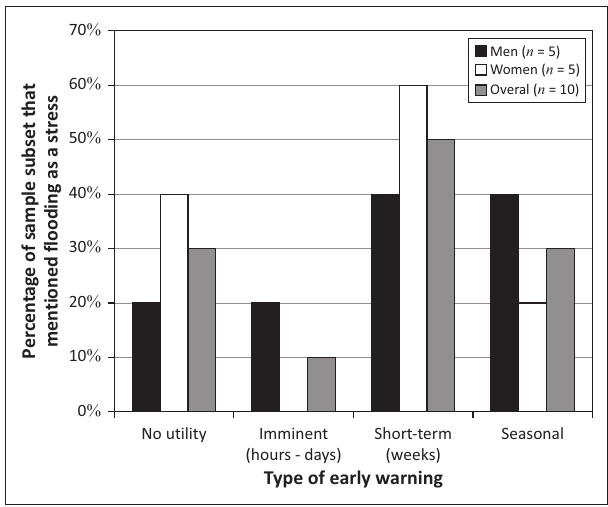
FIGURE 22: Answers of those in Group W who were asked what kinds of early warning would be useful, broken up by